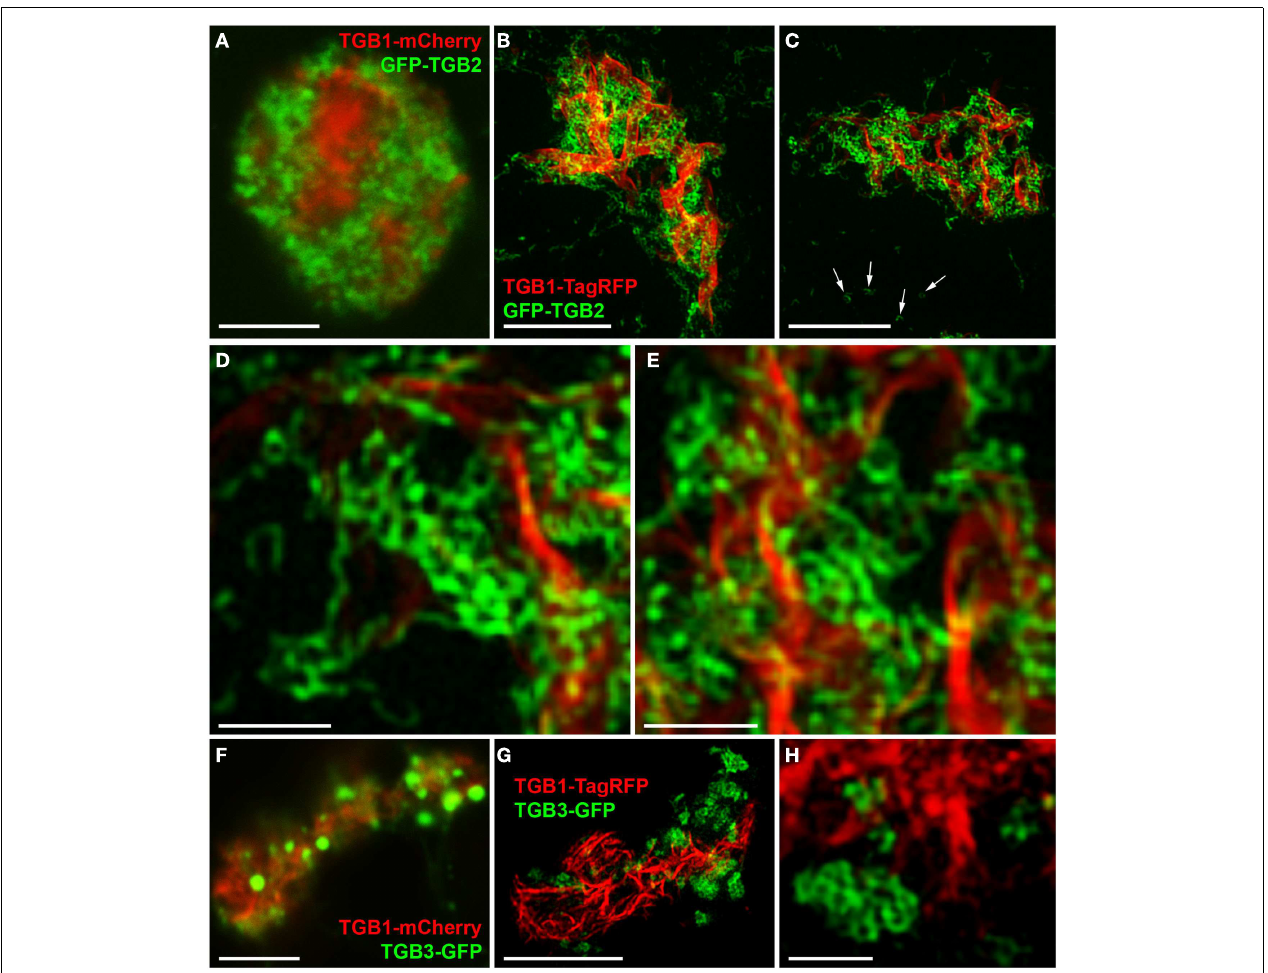
higher magnification (D,E) , the hoop dimensions are apparent and the hoops can be seen winding around theTGB1 aggregates. (F) Live-cell confocal image ofTGB1-mCherry andTGB3-GFP (co-bombarded into PVX-infected cells) show the occurrence ofTGB3 granules or aggregates within the X-body. (G,H) In 3D-SIM images ofTGB1-TagRFP andTGB3-GFP in a pseudo-VRC in an uninfected cell, theTGB3 structures are resolved as hoops similar in size to those labeled byTGB2 and concentrated in clusters or patches outside of the TGB1 inclusion. Bars (A–C) : 5 µ m; (D,E) : 1 µ m; (F,G) : 5 µ m; (H) : 1 µ